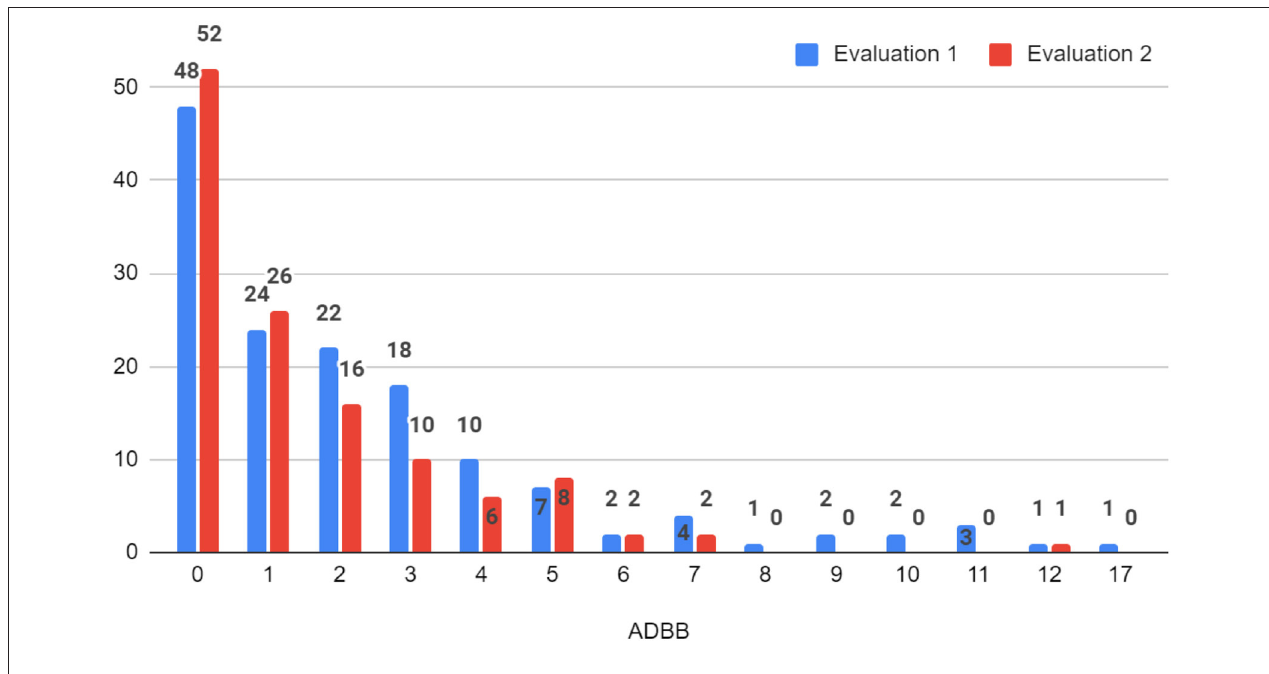
FIGURE 2 | Frequencies of the total scores of the ADBB scale.